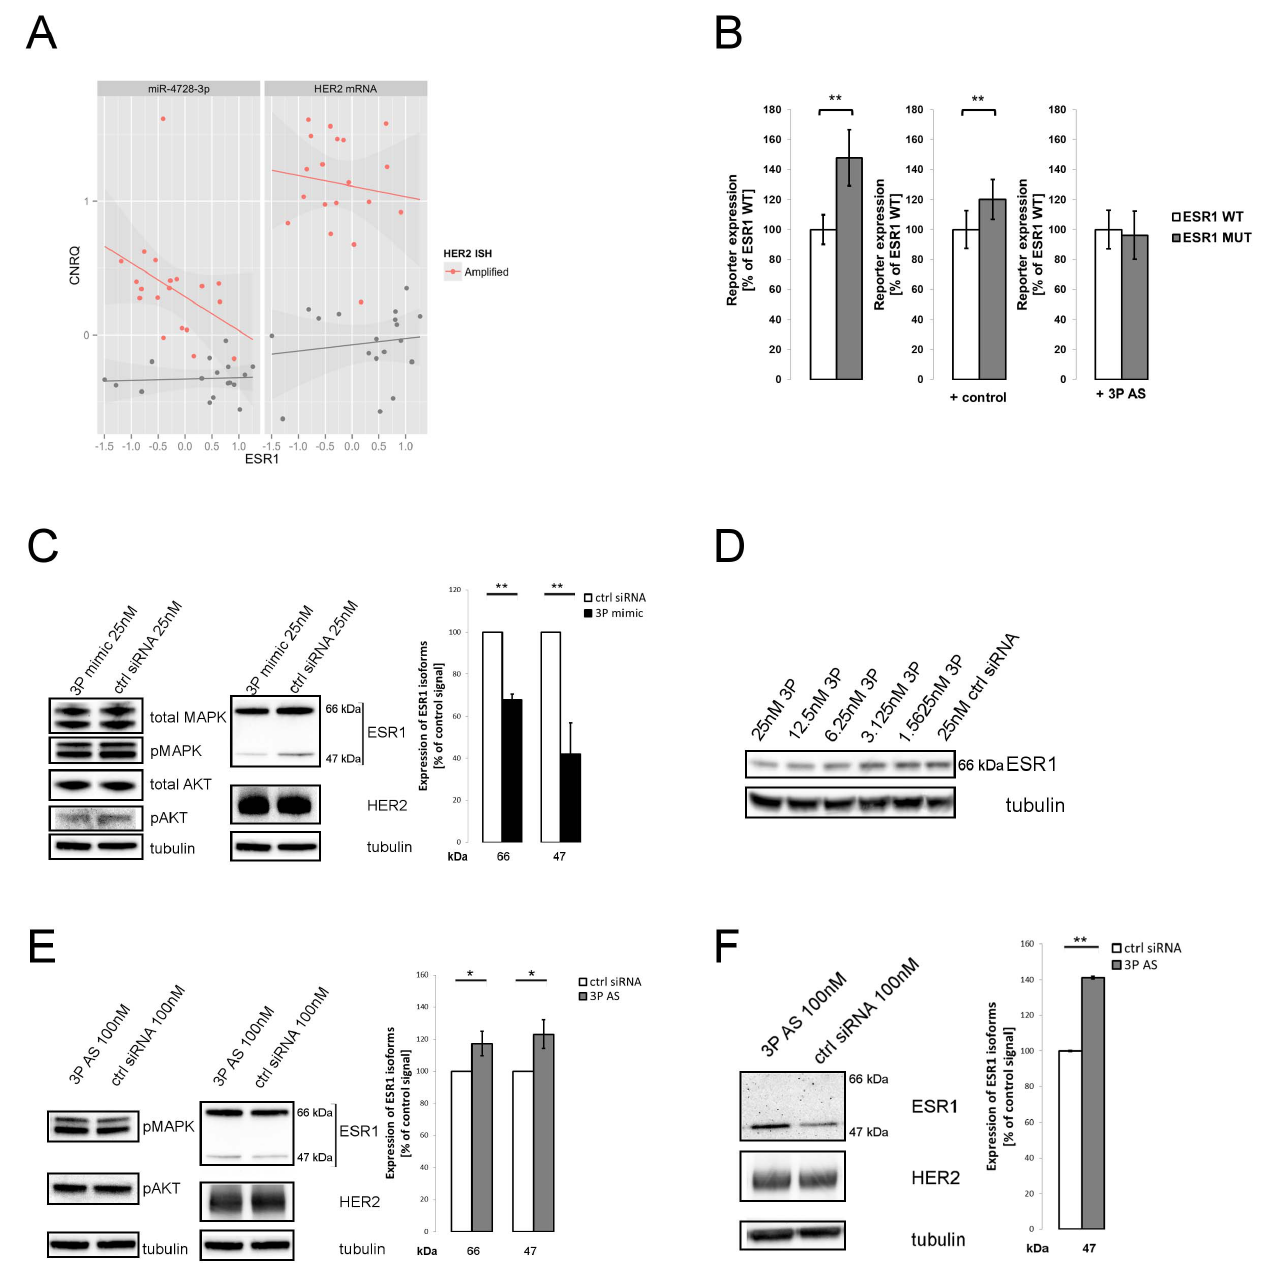
Figure 4. miR-4728-3p IS regulates ESR1. A. qRT-PCR analysis of ESR1 and HER2 transcripts and miR-4728-3p among a panel of 38 breast cancer tumors (19 HER2 + , 19 HER2-). Calibrated Normalized Relative Quantity (CNRQ) of miR-4728-3p (left) and HER2 (right) is plotted against expression levels of ESR1. Tumors classified as HER2 + by ISH are shown in red, HER2- in grey. Expression was normalized to a panel of reference genes. For details see text and material and methods. B. Luciferase assay in BT-474 with ESR1 3 9 UTR constructs carrying either wild type target site of miR-4728-3p internal seed (WT) or mutated internal seed site (MUT). Firefly luciferase activity was normalized against Renilla luciferase. Reporter activity is given as % of WT in respective experiment. Repression of WT ESR1 construct by endogenous miR-4728-3p (left) is alleviated by an antisense oligo (AS) against endogenous miRNA (right) but not by a non-targeting control (middle). C. Western blot (left) and protein quantification (right) of ESR1 in MCF7. The two main isoforms of ESR1 (47 and 66 kDa), plotted as percentage of control signal of matching size, are down regulated upon transfection of miR- 4728-3p mimics. Levels of HER2, (p)MAPK and (p)AKT remain largely unchanged. D. MCF7 cells were transfected with indicated concentrations of miR-4728-3p mimic. ESR1 levels show a concentration-dependent down-regulation that is most pronounced at highest tested concentration (25 nM). E. Western blot (left) and protein quantification (right) of ESR1 in BT474. ESR1 is up regulated when blocking endogenous miR-4728-3p with AS- oligonucleotides, while pMAPK and pAKT remain largely unchanged. F. Western blot (left) and protein quantification (right) of ESR1 in HCC1954 cells. ESR1 isoform of 47 kDa is up regulated under miR-4728-3p blocking. The main 66 kDa isoform is not detectable in this ER- cell line. Signals were quantified with ImageJ and normalized to total protein by Coomassie stain. Tubulin was used as a loading control. Asterisks denote p-values of , 0.05 (*), and , 0.005 (**) in Student 9 s t-test.